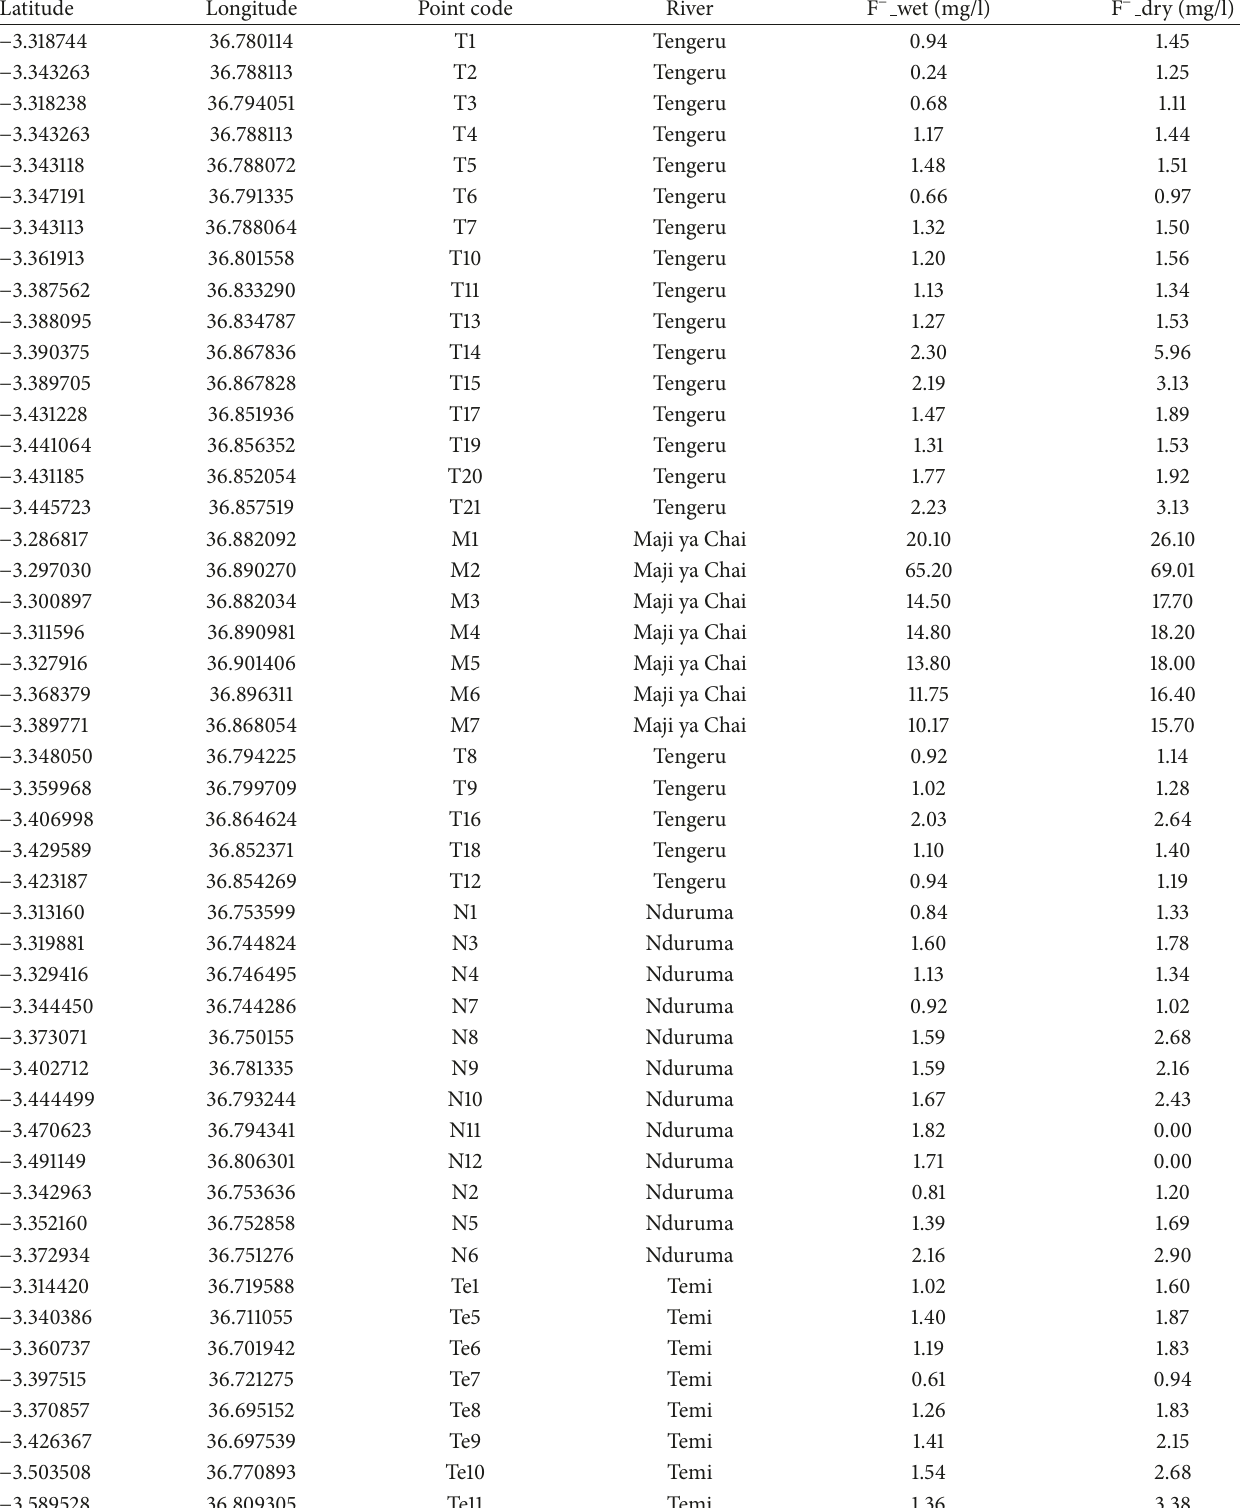
Table 4: Fluoride levels in Temi, Nduruma, Tengeru, and Maji ya Chai